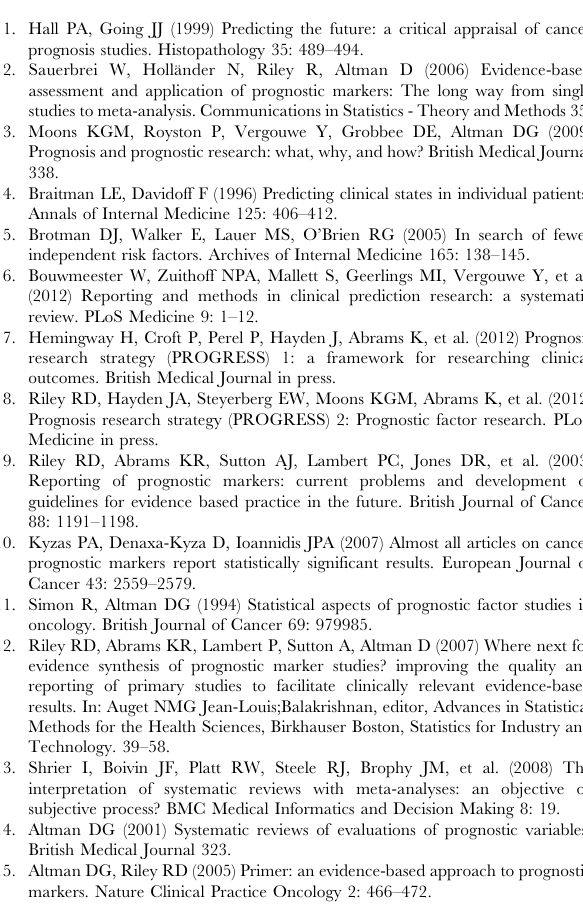
Table S1 Overview of the DVT datasets. Table S2 Overview of the variables in the DVT datasets. Table S3 Additional results Case